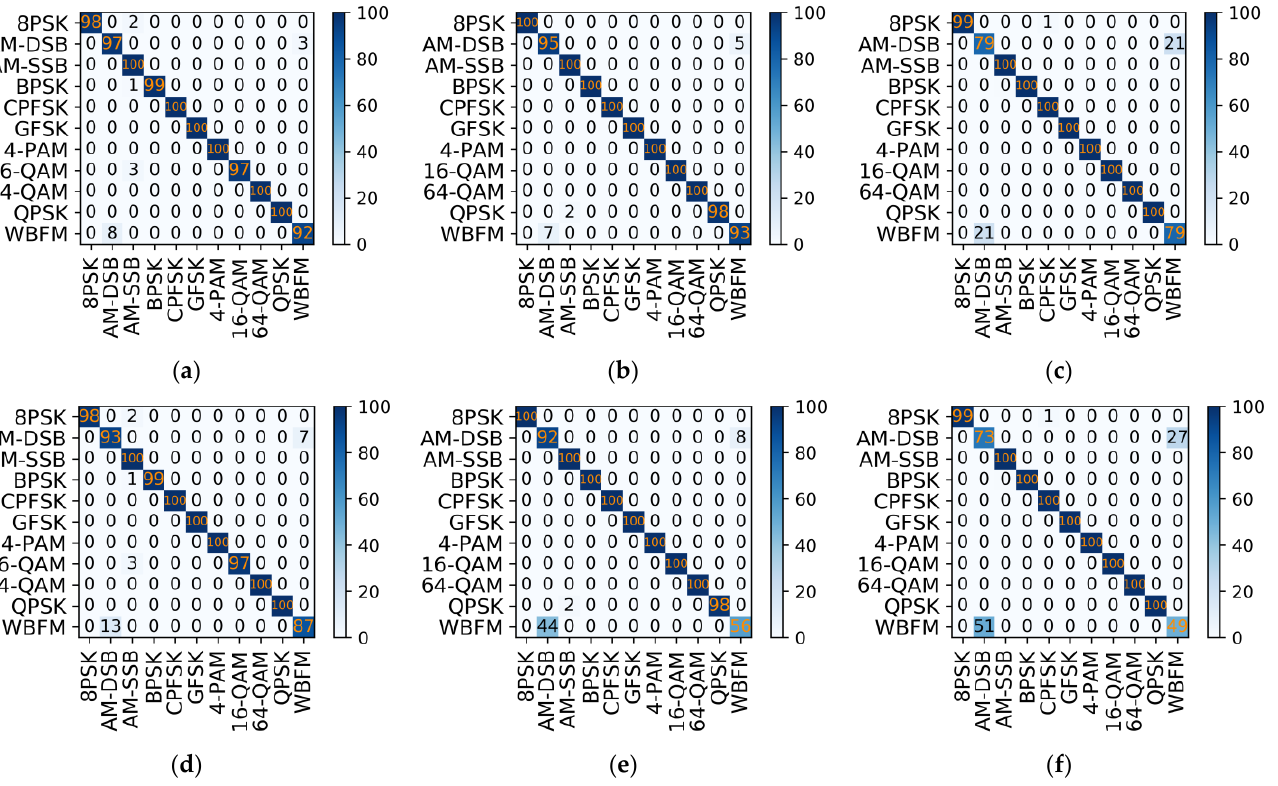
Figure 14. Partial confusion matrices on the RML2016.04c dataset about two networks. ( a ) IQGMCL- 6dB; ( b ) IQGMCL-8dB; ( c ) IQGMCL-14dB; ( d ) MCLDNN-6dB; ( e ) MCLDNN-8dB; ( f ) MCLDNN- 14dB.